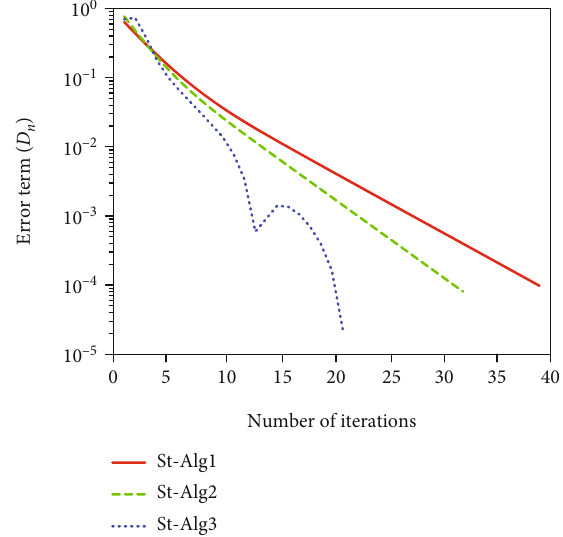
= κ = ð 5 + t 2 Þ /5 . 0 1